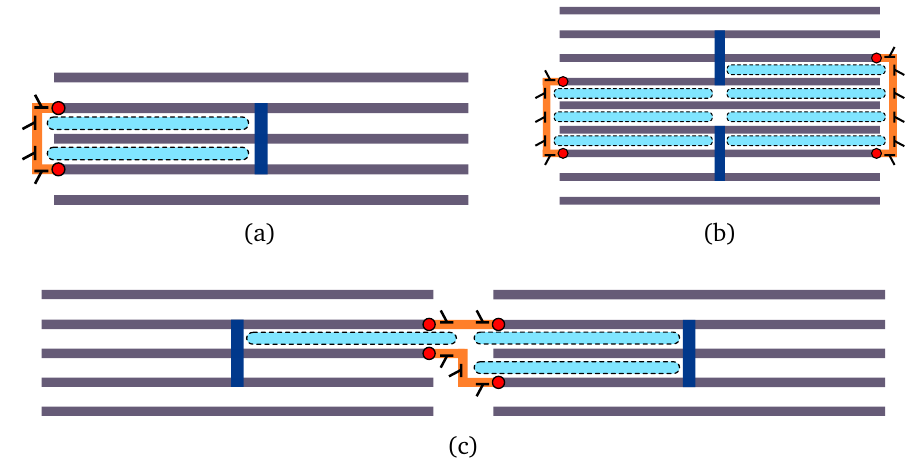
Figure 3: Various fermionic parity measurement configurations for the two-sided = 2 vertical cutter gates hexon architecture. (a) A 2-MZM measurement with n c = 2 units of area enclosed by the interference loop, and n = 2 tunnel- opened, n a t ing junctions to MZMs. (b) A 4-MZM measurement on vertically displaced hexons, = 7, n = 7 , and n = 4 . (c) A 4-MZM measurement on horizontally dis- with n c a t = 1 , n = 3 , and n = 4 . placed hexons, with n c a t